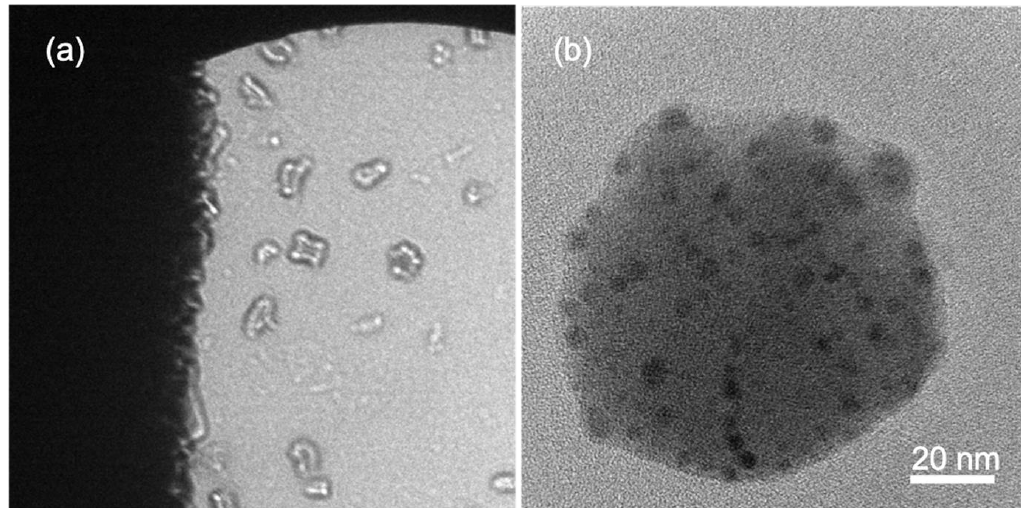
Figure 10. ( a ) In-line hologram of biologic particles. ( b ) Low-magnification HRTEM of one of